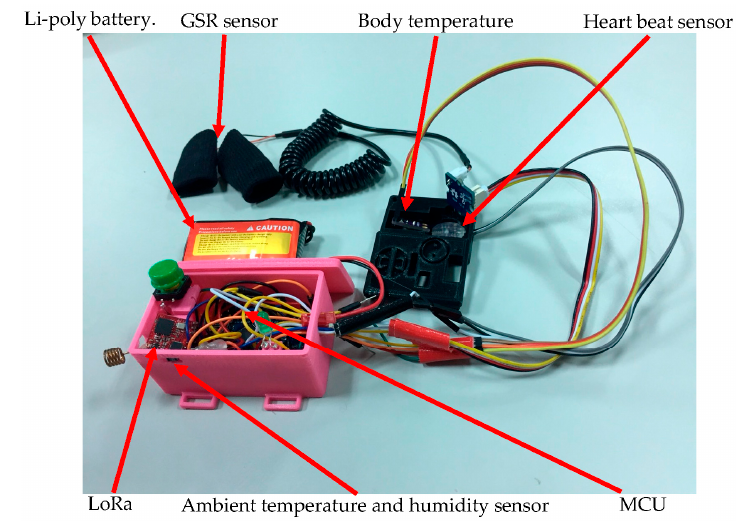
Figure 5. The configuration of individual sensors and components in the WHDD.